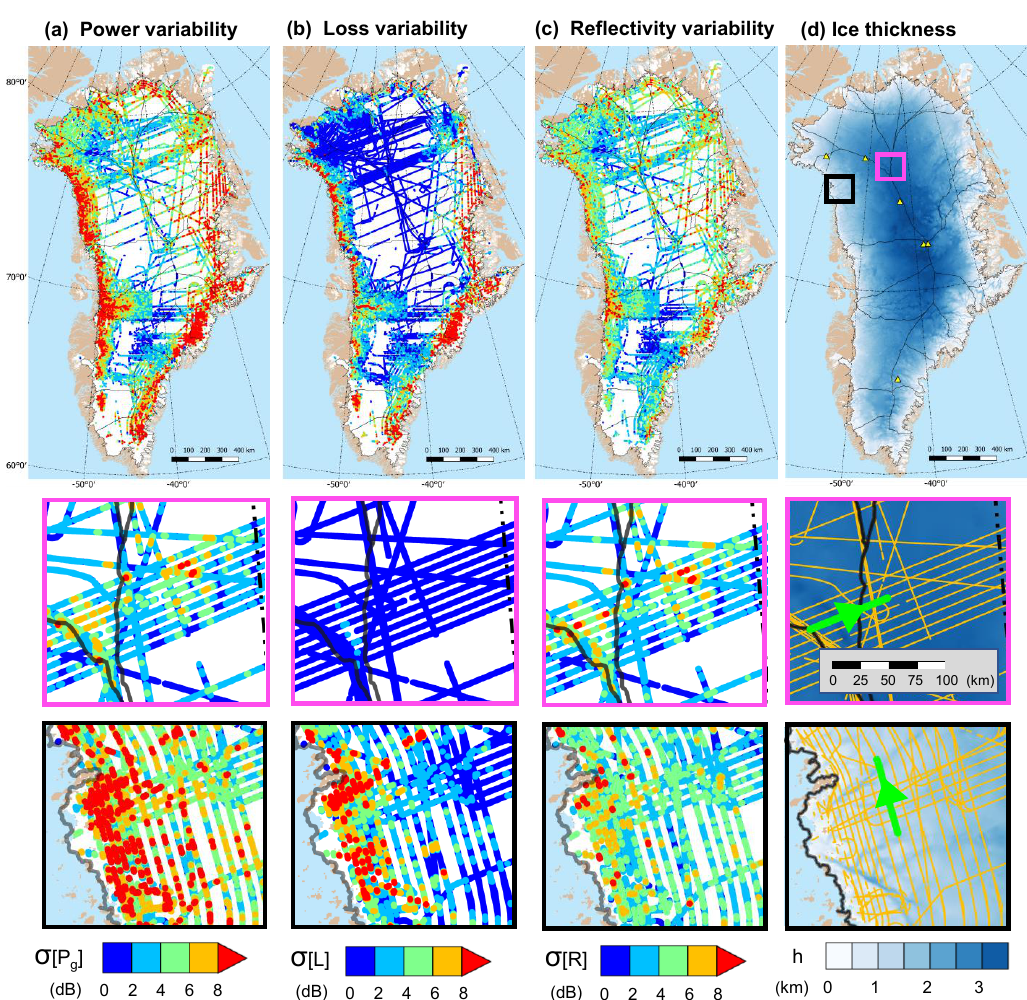
Figure 3. Spatial distributions for (a) bed-echo power variability σ [ P , (b) attenuation loss variability σ [ L ] , (c) bed-echo reflectivity variabil- g ] ity σ [ R ] and (d) ice thickness, h . Zoomed-in panels with flight-track data at true buffer size (5km) are shown for the north-central ice sheet (pink bounding box, containing profile in Fig. 2a) and north-western margins (black bounding box, containing profile in Fig. 2b). The profiles are indicated in bold green in the ice thickness zoomed-in panels. In panels (a–c) higher variability data is stacked on top of lower variability data, which acts to emphasise higher variability. The zoomed-in panels all have the same scale ( × 8 the resolution of the ice-sheet-scale